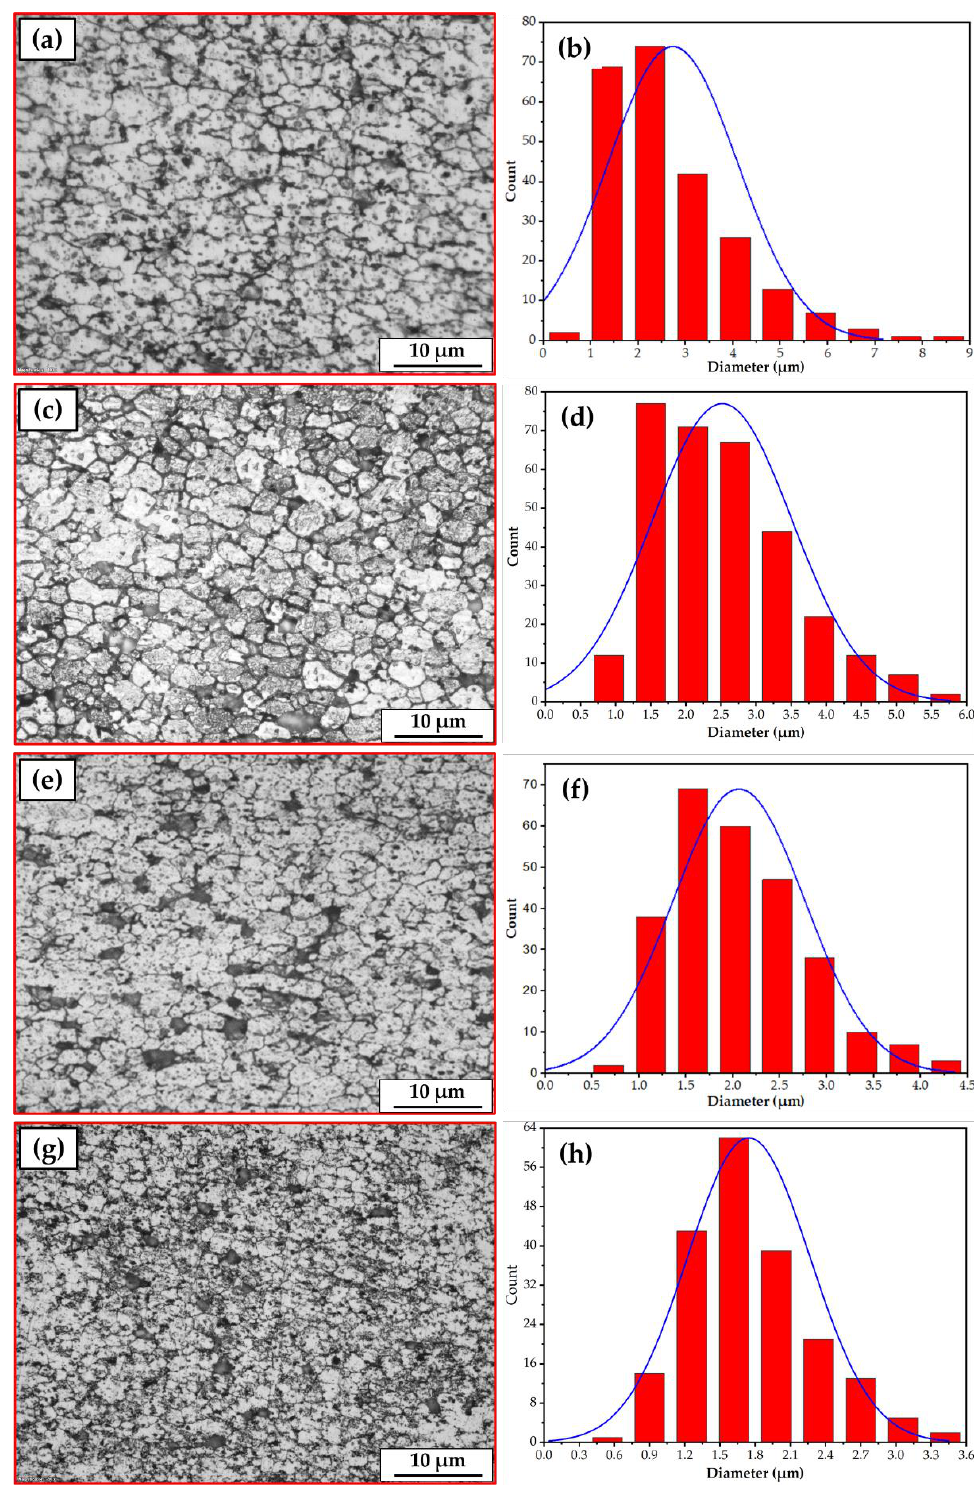
Figure 12. The microstructures of the deposited ( a ) AA2011-T6 AMP; ( b ) AA2011-O AMP; ( c ) AA2011-T6/Al 2 O 3 composite; ( d ) AA2011-O/Al 2 O 3 composite produced at a rotation speed of 800 rpm and a 5 mm/min feeding rate. The grain size analysis of the produced AMPs of ( e ) AA2011-T6 and ( f ) AA2011-O. ( g ) The AMCPs using the temper condition AA2011-T6 and ( h ) the AMCPs using the temper condition AA2011-O.